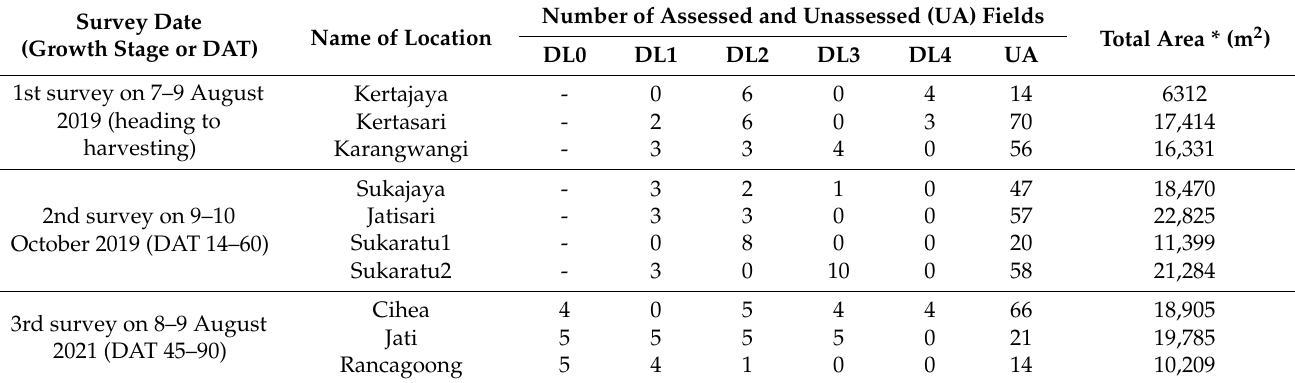
Table 1. Information on each location and assessments by PO.